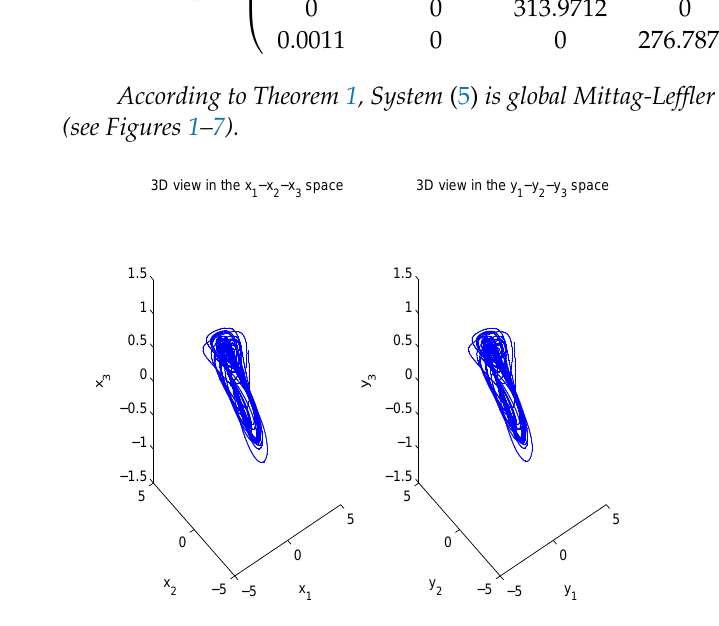
Figure 1. Three-dimensional view synchronization for fractional-order 0.95.